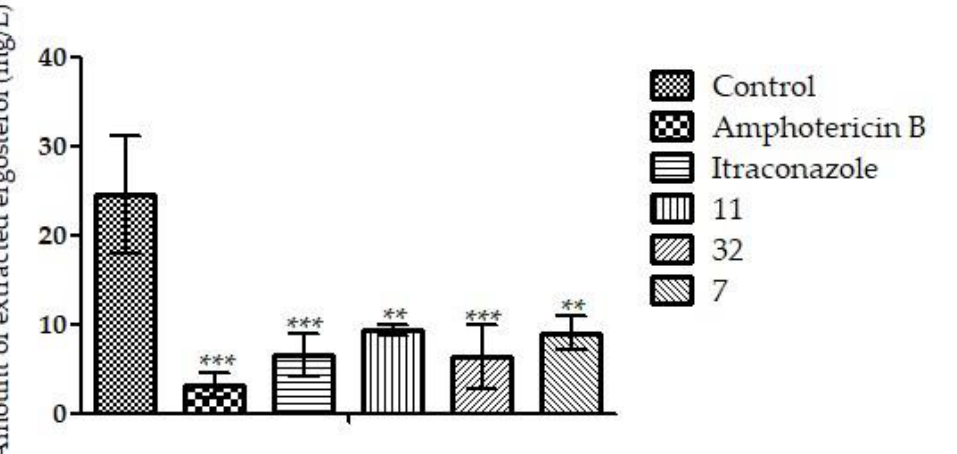
Figure 9. The graphic shows the amount of extracted ergosterol of fungal H. capsulatum EH-315 treated with 11 , 32 , 7 , ITZ, and AmB. In the treatment with compounds 11 , 32 , and 7 , the amounts of sterols extracted were reduced, indicating that these compounds may act on the ergosterol synthesis or chain. AmB and ITZ also reduced the amount of steroids due to their mechanisms of action in the membrane and on the synthesis chain, respectively. ** p < 0.01; *** p < 0.001.